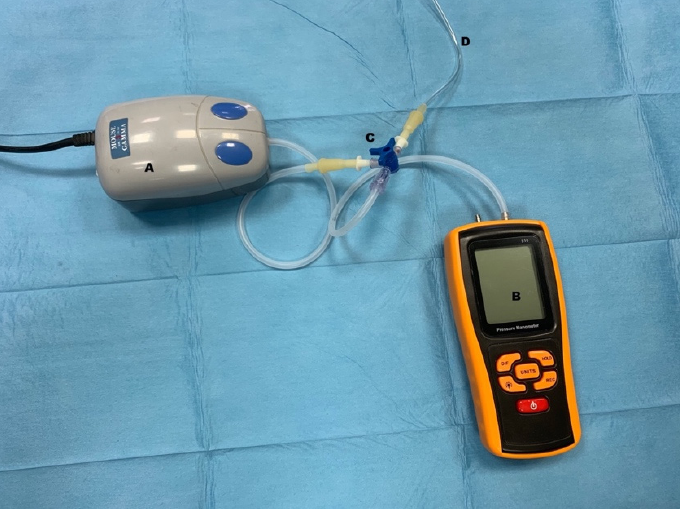
Figure 3. Image of instrumentation used for burst pressure (BP) test. A: air pump; B: manometer; C: three-way stopcock; D: tube to the construct.